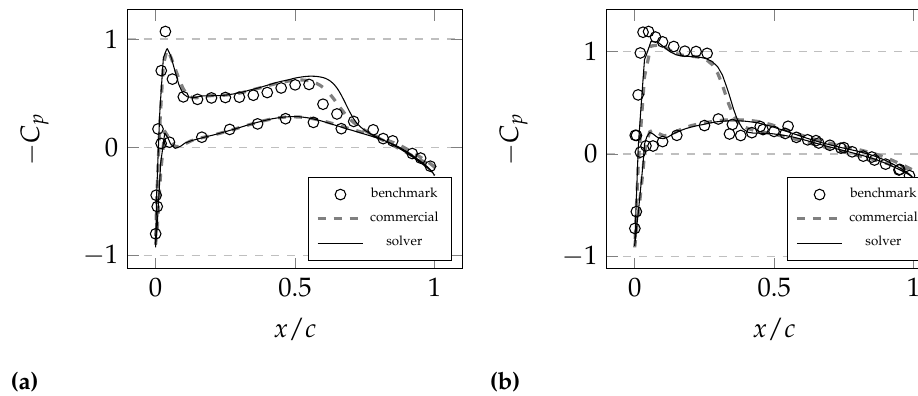
Figure 28. Schematic of the ONERA wing showing a top-view and the two associated section lines along which the pressure coefficient is measured